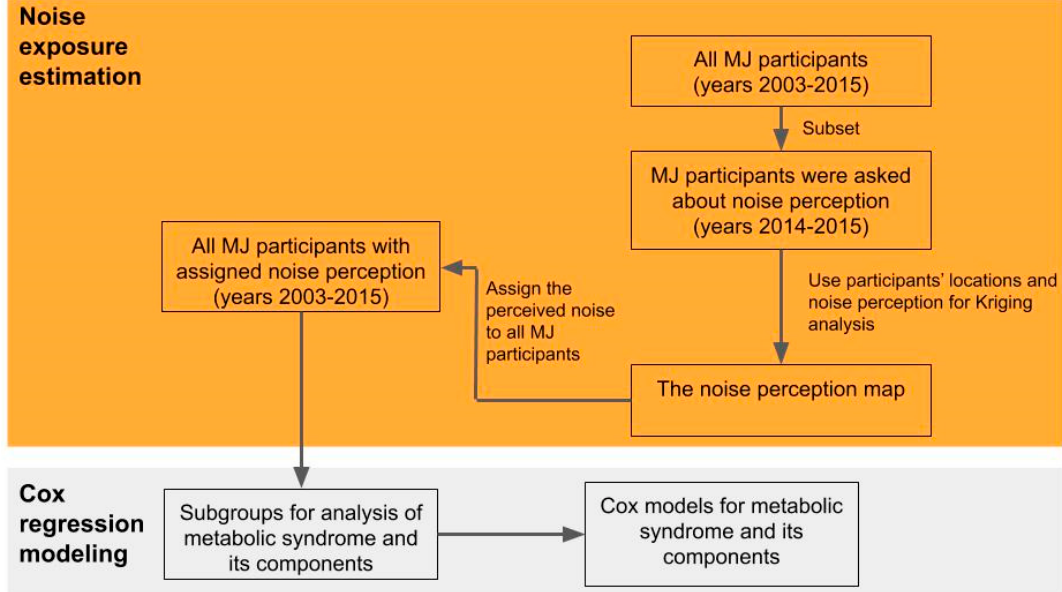
Figure 1. Flowchart of this study. This study first estimated the noise exposure for each MJ health screening participant, then Cox regression models were applied to estimate the hazard ratios of metabolic syndrome and its components under different levels of noise exposure.